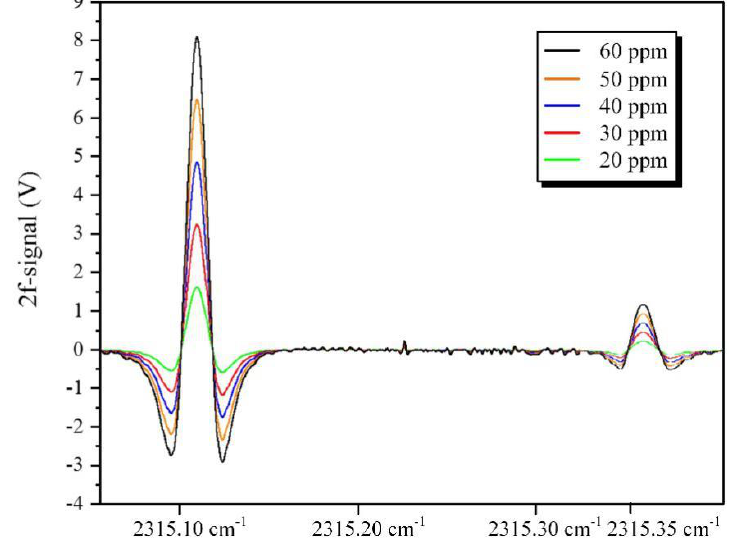
Figure 5. Second harmonic signals with the background absorption removed, obtained from five different concentrations (20, 30, 40, 50, and 60 ppm).